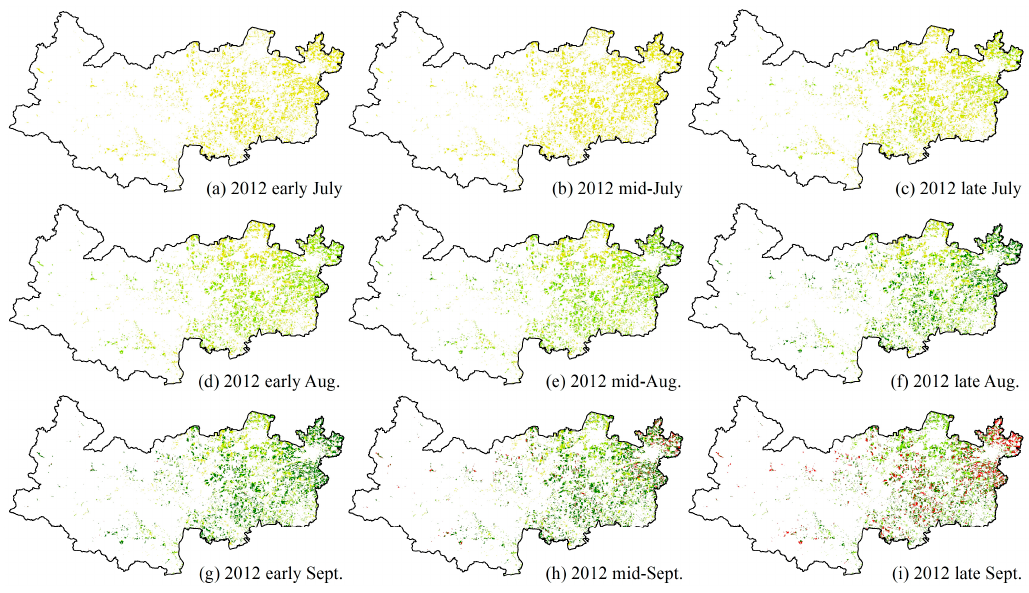
Figure 8. Results of dynamic mapping of LAI for single-cropped rice in Deqing County in 2013.